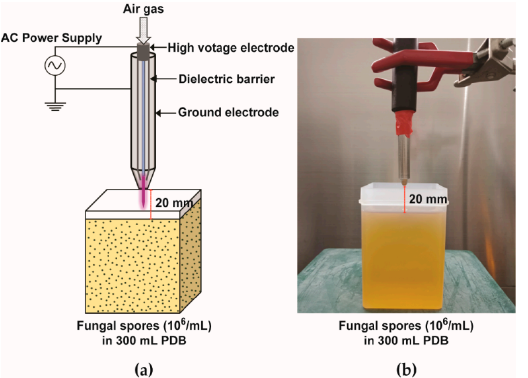
Figure 1. Non-thermal atmospheric pressure plasma jet device. ( a ) Schematic view of the plasma jet device and the experimental set-up for fungal spore treatment with plasma. ( b ) Photograph of treatment of the fungal spore suspension with the plasma